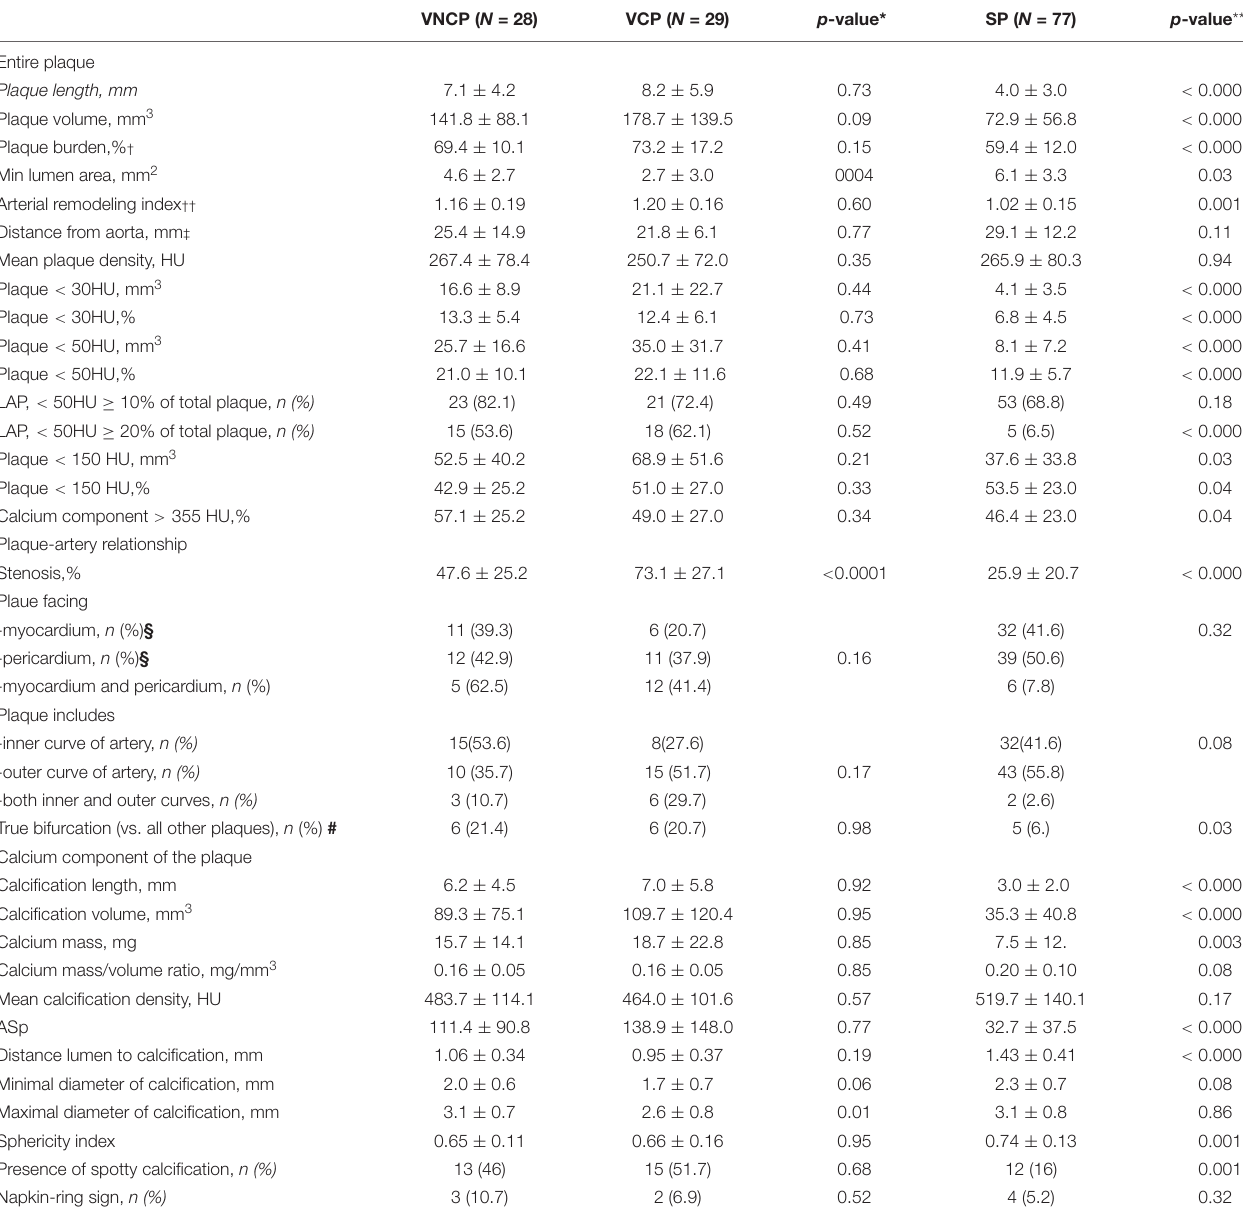
TABLE 3 | Univariate analysis of the comparison of calcified plaques depending on the vulnerability profile by CCTA ( N = 134). VNCP ( N = 28) VCP ( N = 29) p -value* SP ( N =